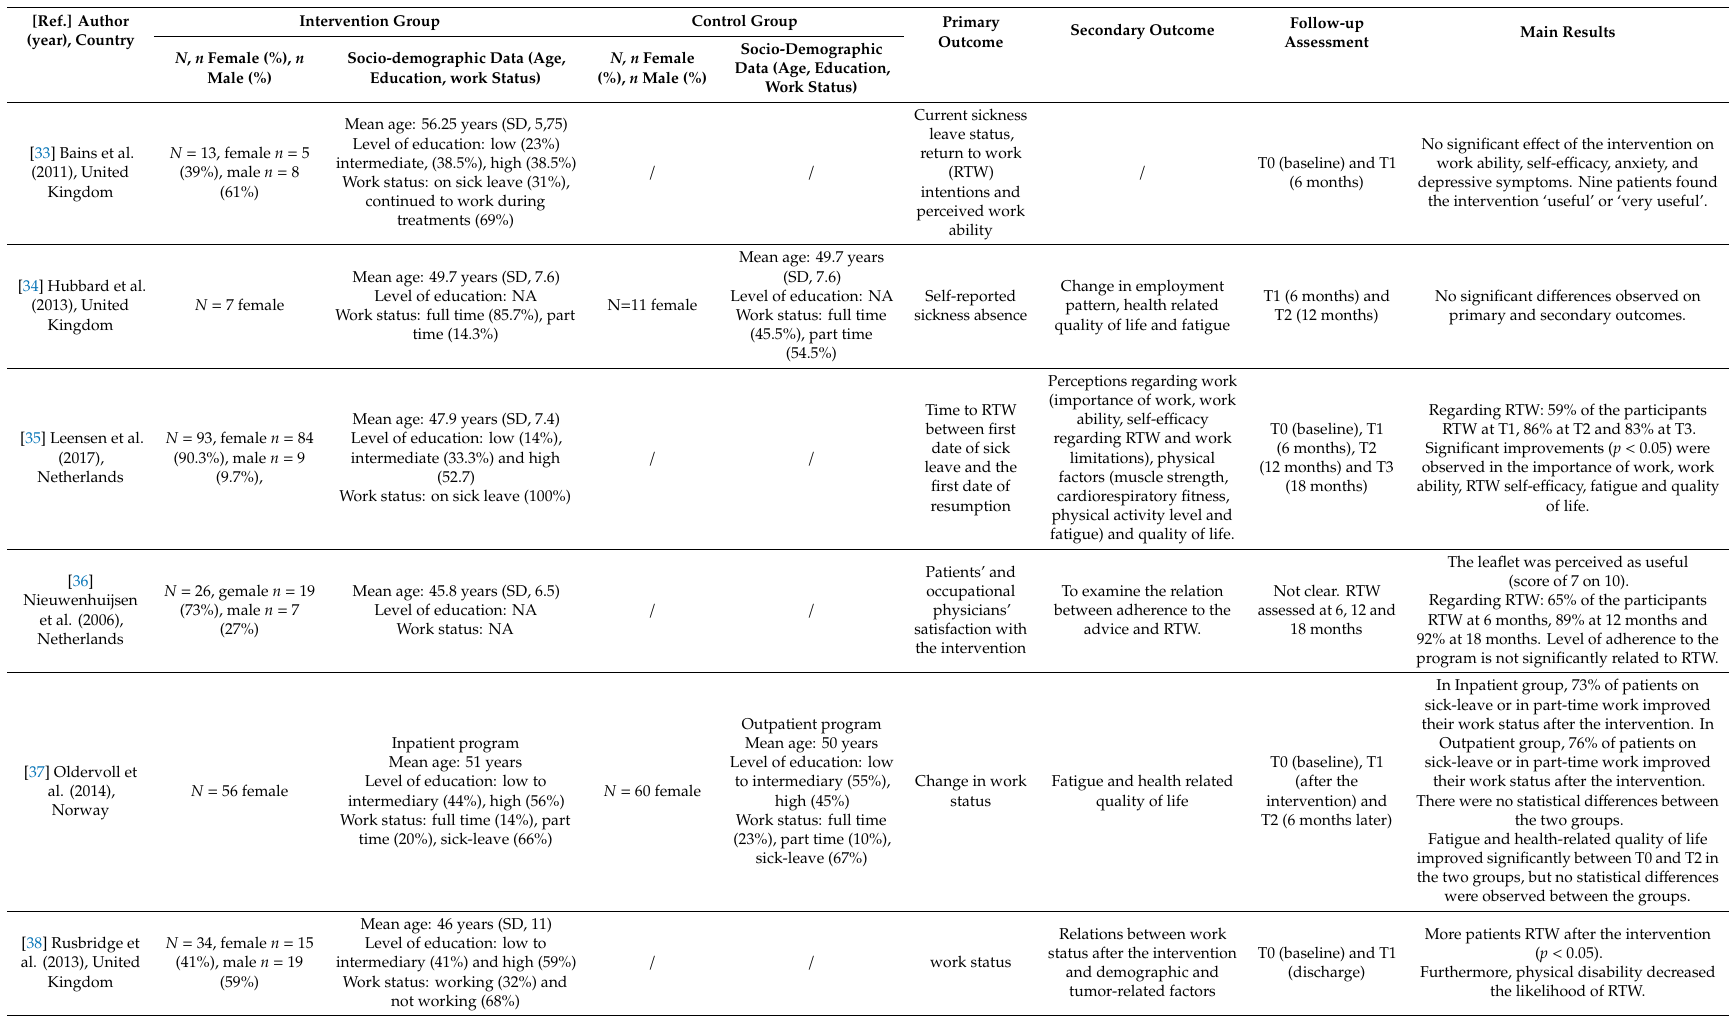
Table 4. Results of the interventions and outcomes measured in the included